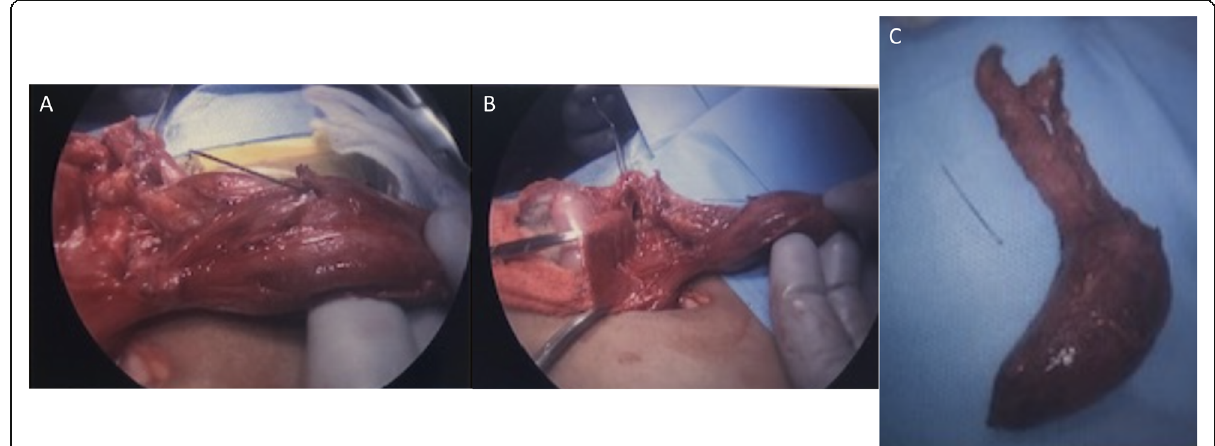
Fig. 5 Surgical removal of incarcerated appendix. a Needle protruding from lumen. b Appendix containing needle to the right, testis to left.